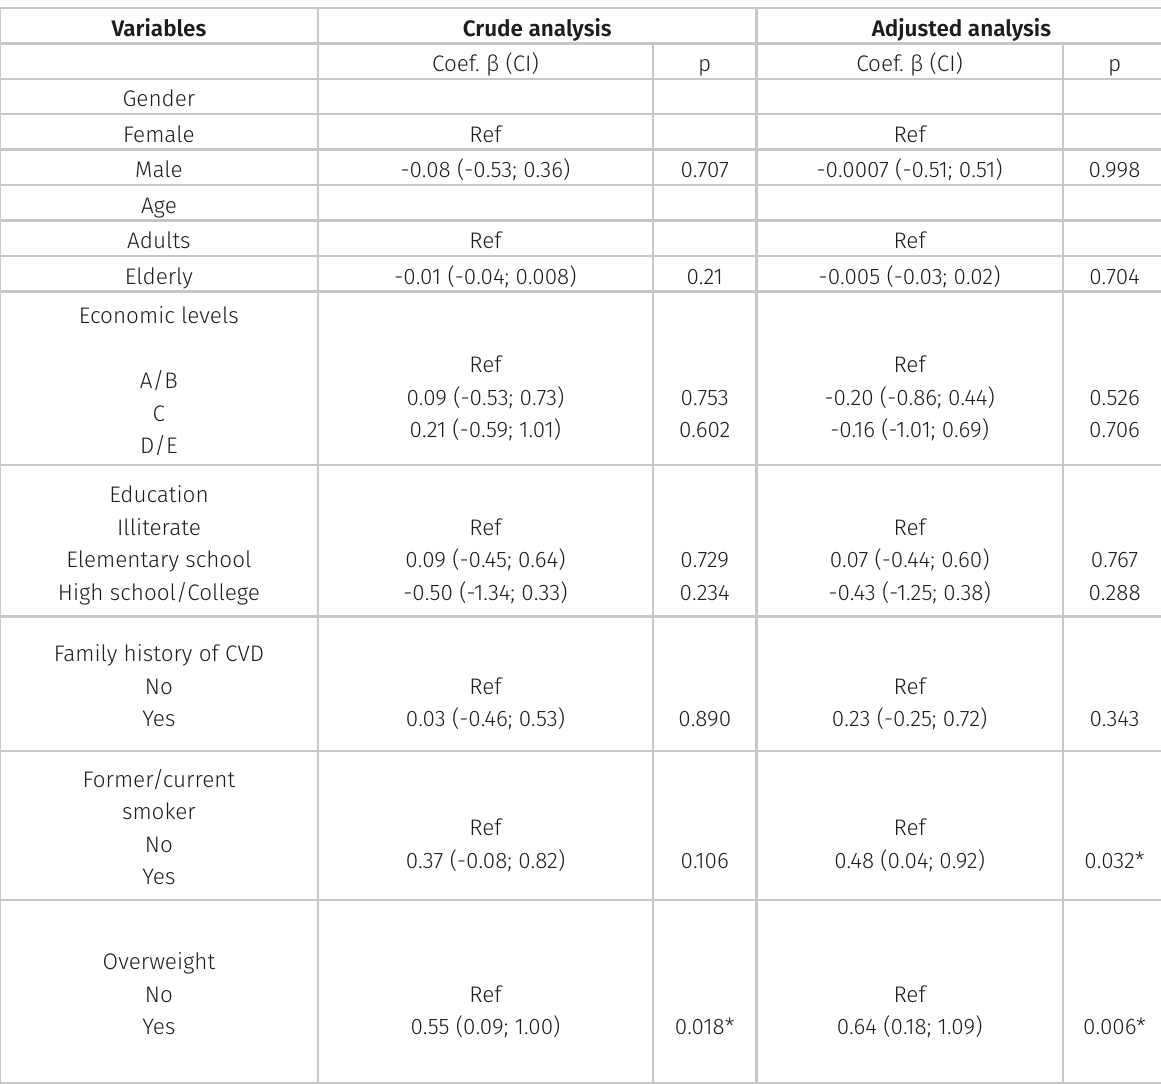
Table III. Crude and adjusted analyses for number of components of metabolic syndrome according to sociodemographic, clinical and anthropometric characteristics of patients with established atherosclerosis disease in Pelotas, RS,